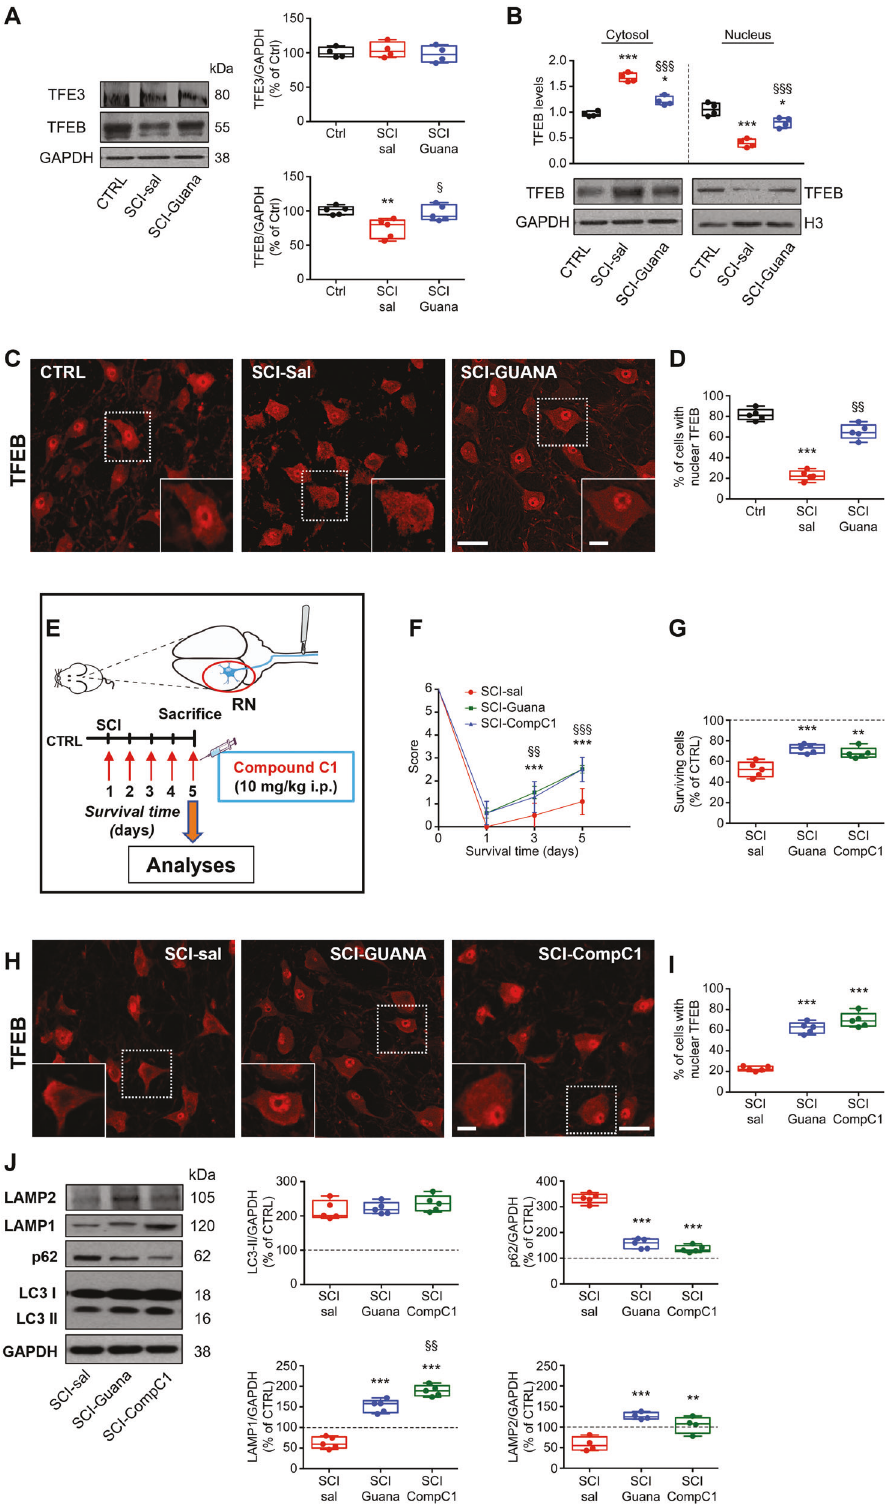
con fi rmed that SCI-induced activation of the apoptotic cascade, as evidenced by caspase-3 activation and TUNEL assay, clearly indicating the commitment of rubro-spinal neurons irreversibly toward death that was signi fi cantly halted by guanabenz